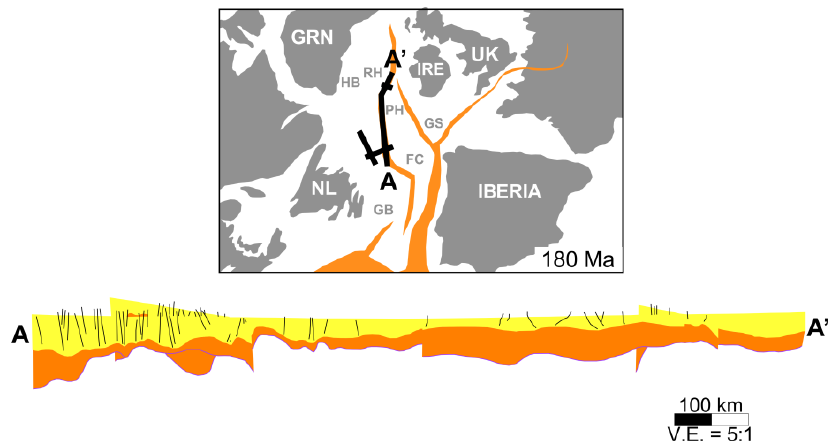
Figure 10. Simplified map of reconstruction from [24] at 180 Ma showing modern landmasses (gray), rifts (orange), and locations of the investigated seismic lines (thick black lines) above a 3D reconstruction from NL3 to IR1 (A to A’ on the map). Note that the locations of the seismic lines on the map are an approximation, as the [24] model is proprietary and not available for academic use. Note also that the 2D geological model for NL1 is not included in this plot. Black lines represent primary faults and red lines represent secondary faults. For meaning of layer colours, see legend in Figure 6.